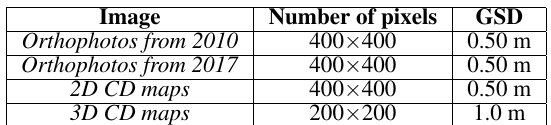
Figure 7. Pixel distribution in test